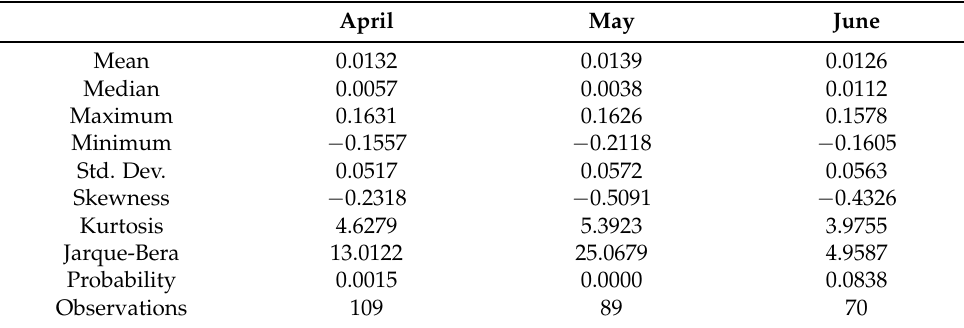
Table 1. Descriptive statistics: Bitcoin futures returns.